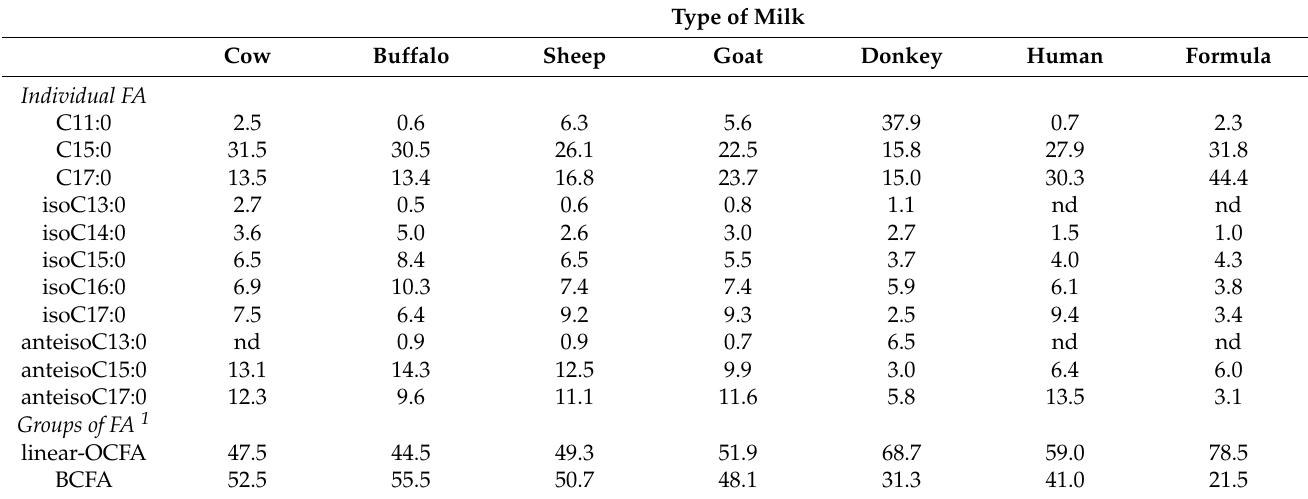
Table 2. Percentage of individual odd and branched fatty acids of the total of OBCFA considered. Type of Milk Cow Buffalo Sheep Goat Donkey Human Formula